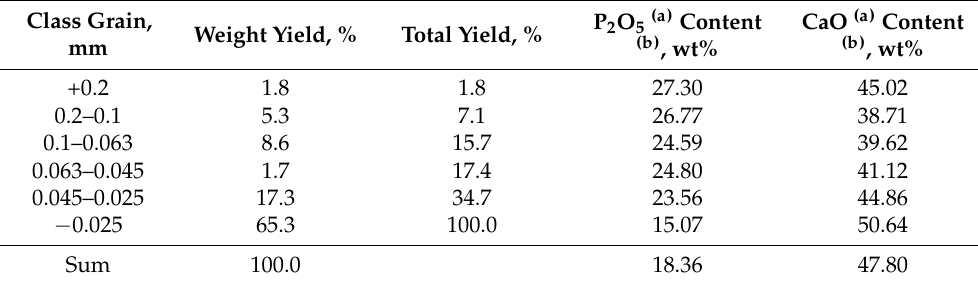
Table 9. Wet grain analysis results, and phosphorus and calcium contents in separated